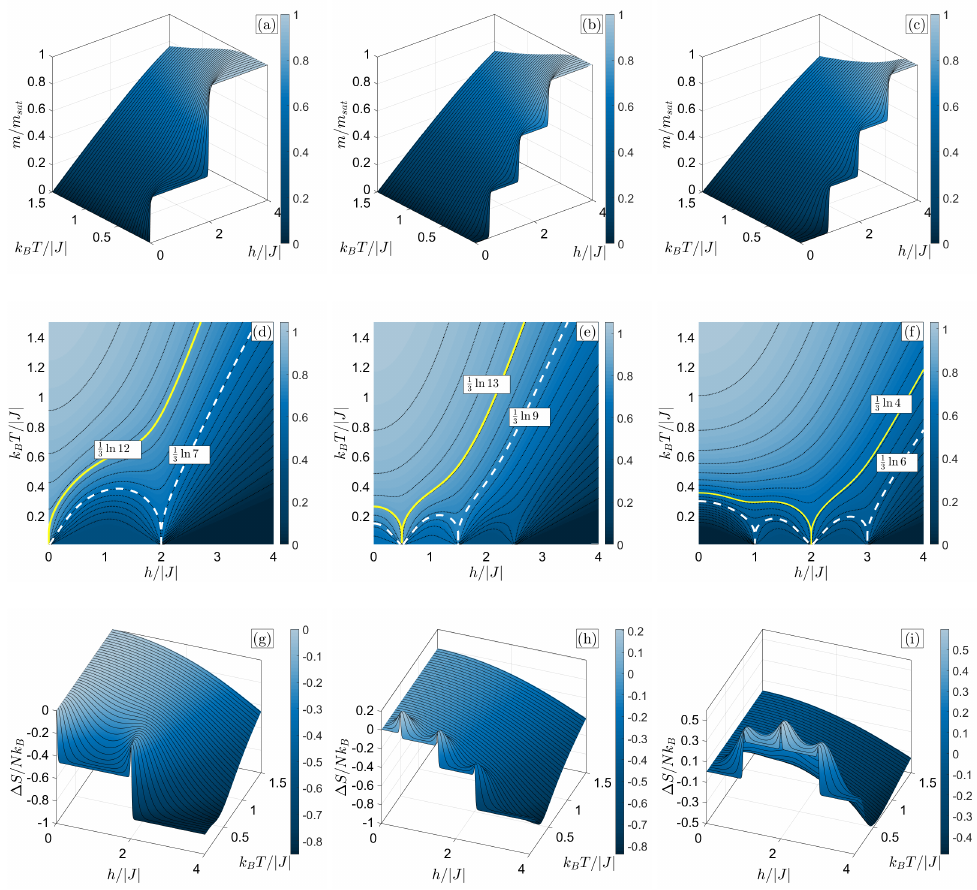
Figure 4. Magnetization ( a – c ), entropy density ( d – f ), and isothermal entropy density change ( g – i ) in k B T / | J | − h / | J | plane, for T cluster with s = 1 and D / | J | = 0 ( a , d , g ), D / | J | = − 0.5 ( b , e , h ), and D / | J | = − 1 ( c , f , i ). The highlighted isentropes in the middle row correspond to the GS residual entropies at the first two critical fields h c 1 / | J | (solid yellow) and h c 2 / | J | (dashed